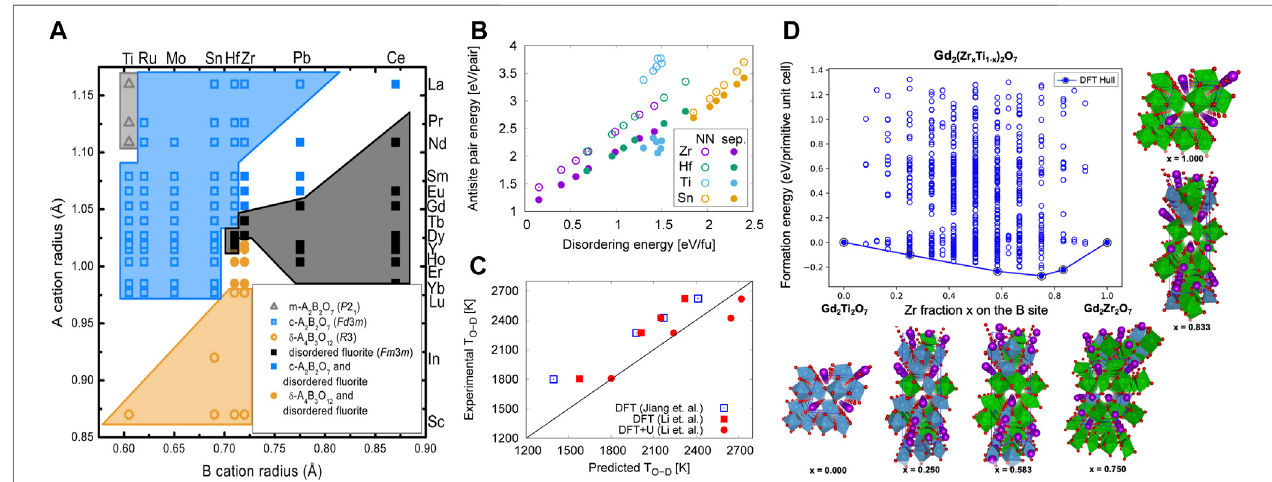
FIGURE 2 | (A) Structure map for A 3 +B 4 +O 4 – x compounds from experimentally reported structures. Hollow gray triangles denote the monoclinic A 2 B 2 O 7 structure,hollowbluesquaresdenoteA 2 B 2 O 7 pyrochlore,andholloworangecirclesdenotetherhombohedral Γ -phaseA 4 B 3 O 12 .Solidblacksquaresdenotedisordered fl uorite. Solid symbols of the same shape as stable ordered structures denote that both the ordered structure and disordered fl uorite have been observed. Reproduced from(Staneketal.,2009). (B) Formationenergyofcationantisitepairsinfourfamiliesofrareearth(RE)pyrochlores,RE 2 B 2 O 7 (B (cid:2) Zr,Hf,Ti,Sn),asafunctionoftheir disordering energies (calculated as described in (Jiang et al., 2009) and antisite separation distance. The formation energies when antisites are nearest neighbors (NN) and are separated (sep.) are shown with fi lled and open symbols, respectively. Adapted from (Uberuaga et al., 2014). (C) Comparison of the calculated order-disorder (O – D)transitiontemperaturewithexperimentaldata(StanekandGrimes,2002)and(Rushtonetal.,2004)forselectedpyrochlores.TheDFTresultsby(Jiangetal.,2009) and(Lietal.,2015)areshowninblueandredsquares,respectively,andtheDFT+Uresultsby(Lietal.,2015)areshowninredcircles.Reproducedfrom(Lietal.,2015). (D) Calculatedmixingenergiesperprimitiveunitcellforthe704uniquecon fi gurationsenumeratedwithintheGd 2 (Zr x Ti 1 – x) 2 O 7 chemistries.TheDFTpredictedconvexhull is represented as a solid line. The atomistic con fi gurations for the identi fi ed ground-state ordered structures on the convex hull are illustrated using purple and red spheres for Gd and O, respectively, while Ti and Zr polyhedra are depicted in blue and green colors, respectively. Reproduced from (Pilania et al., 2019).